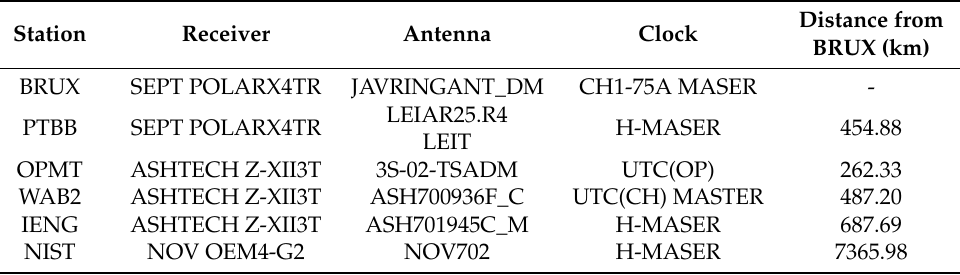
Table 2. Details of the selected IGS